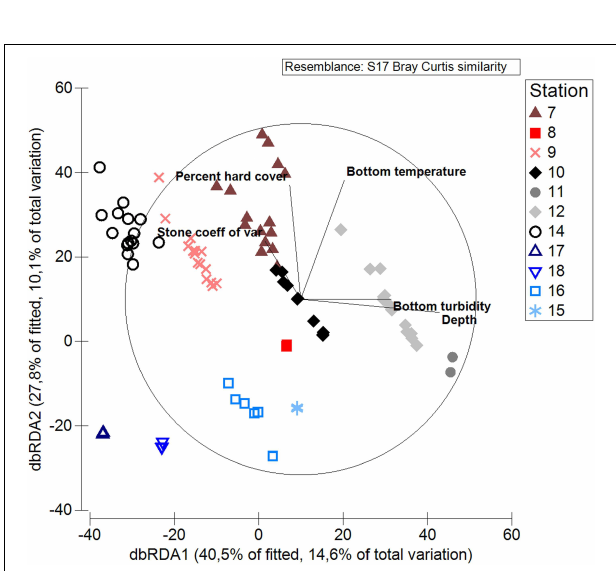
showed lower faunal diversity, plus a lower variety of func- tional traits (primarily mobile scavengers with rare sessile sus- pension feeders, Figure 9 ). Stations in Raudfjorden had turbid bottom water ( Figure 3 ), indicating heavy disturbance from glacial sedimentation, re-suspension, and/or terrestrial